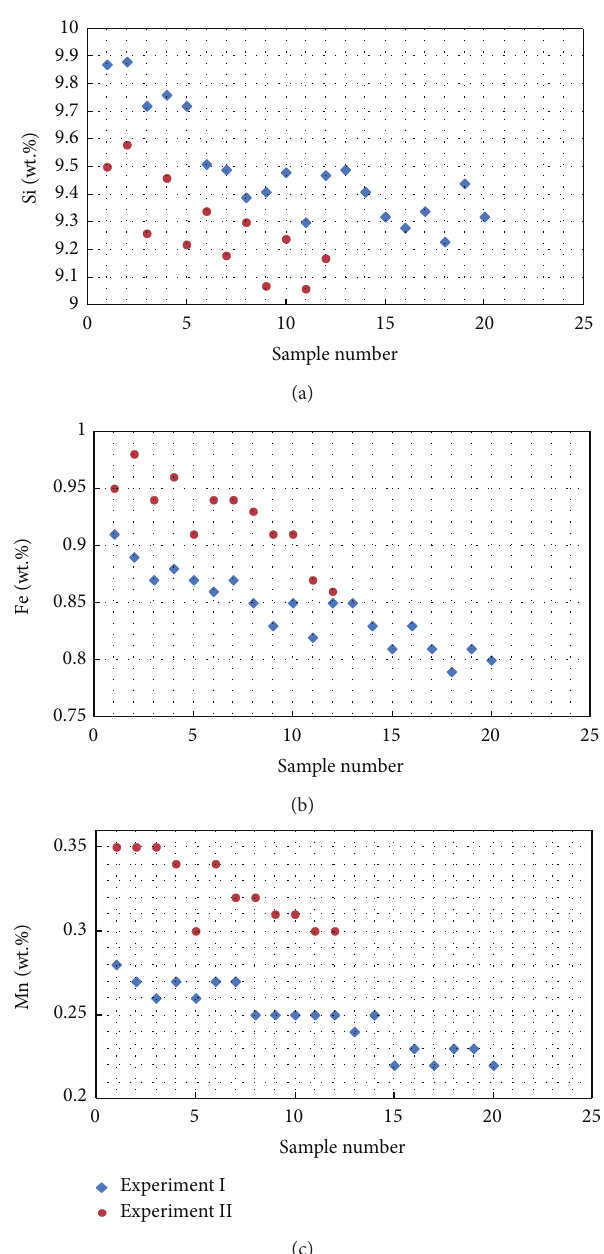
Figure 1: Values of chemical composition (Si/Fe/Mn) for the exper-